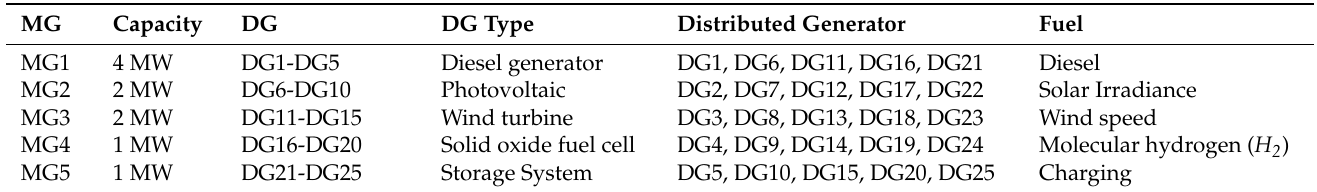
Table 2. Microgrid units in the distribution